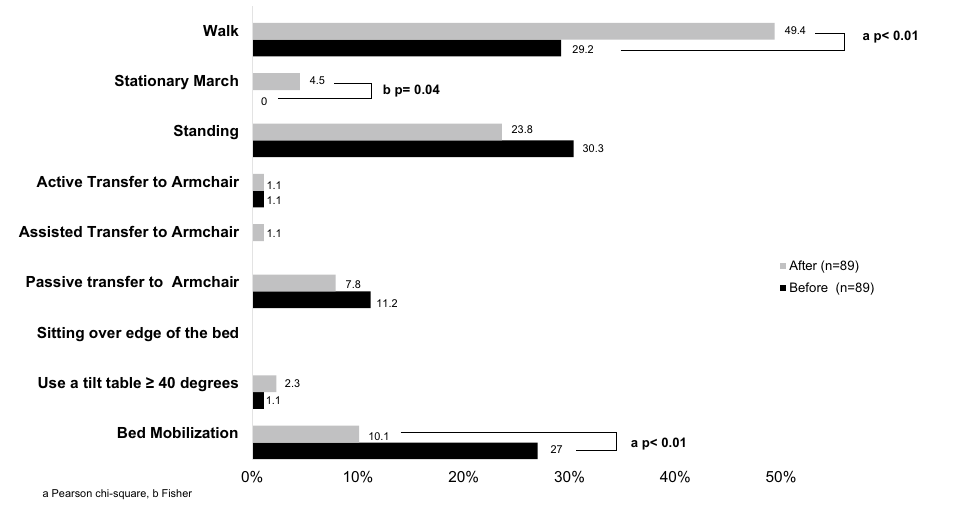
Figure 5. Proportion of highest mobility landmark achieved.